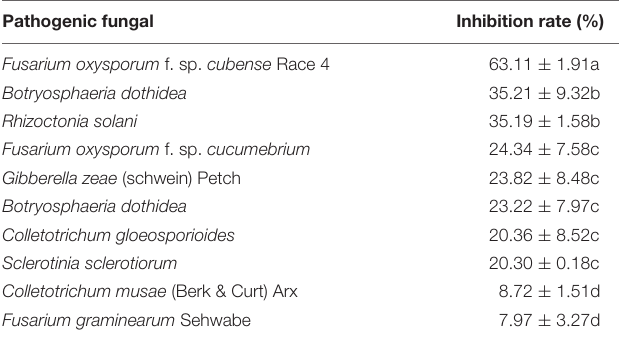
TABLE 4 | Antifungal activity of strain HN6 volatile organic